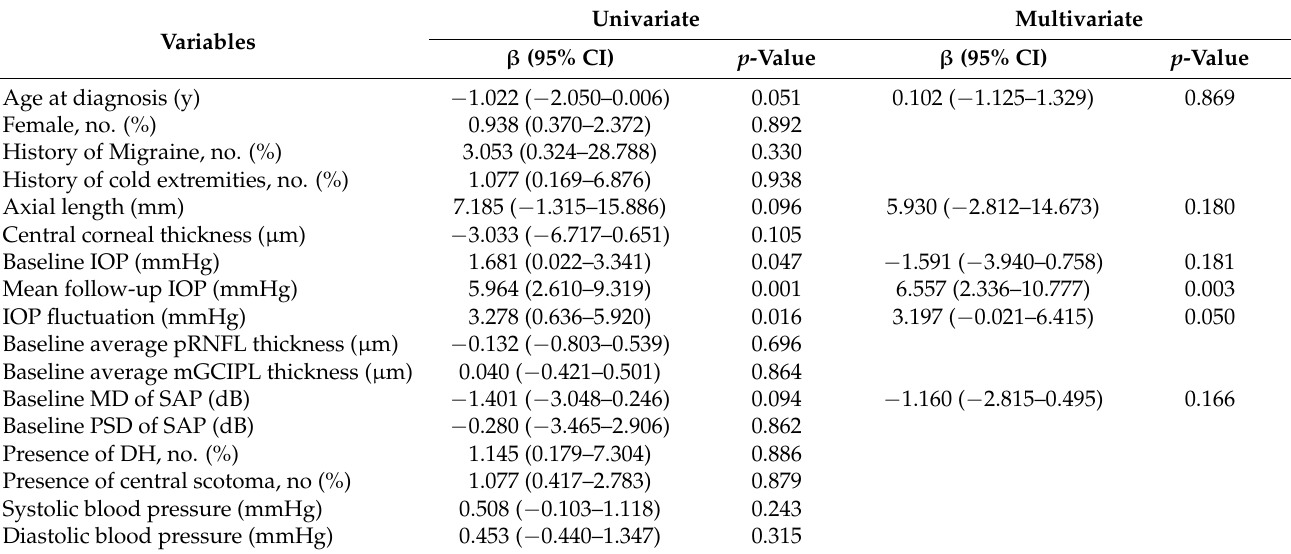
Table 3. Factors associated with the level of TNF- α in the aqueous humor of open-angle glaucoma patients.